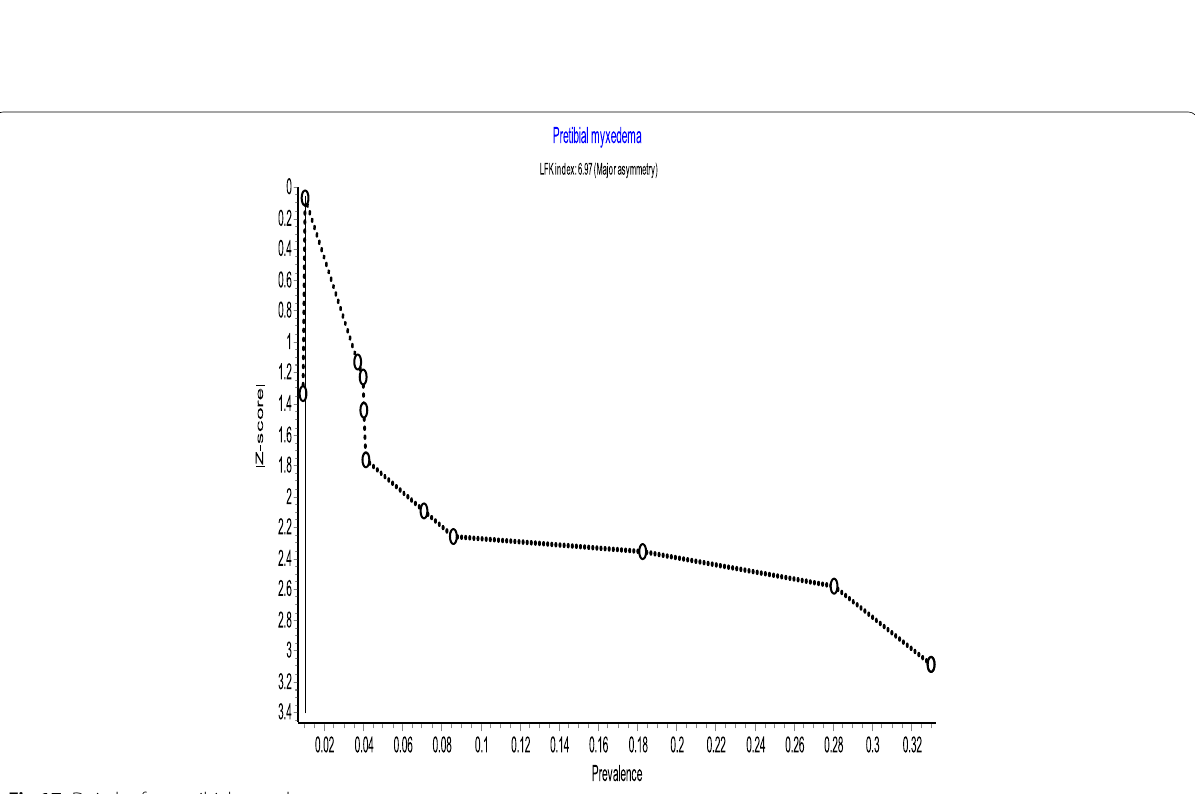
Fig. 16 Doi plot for goiter